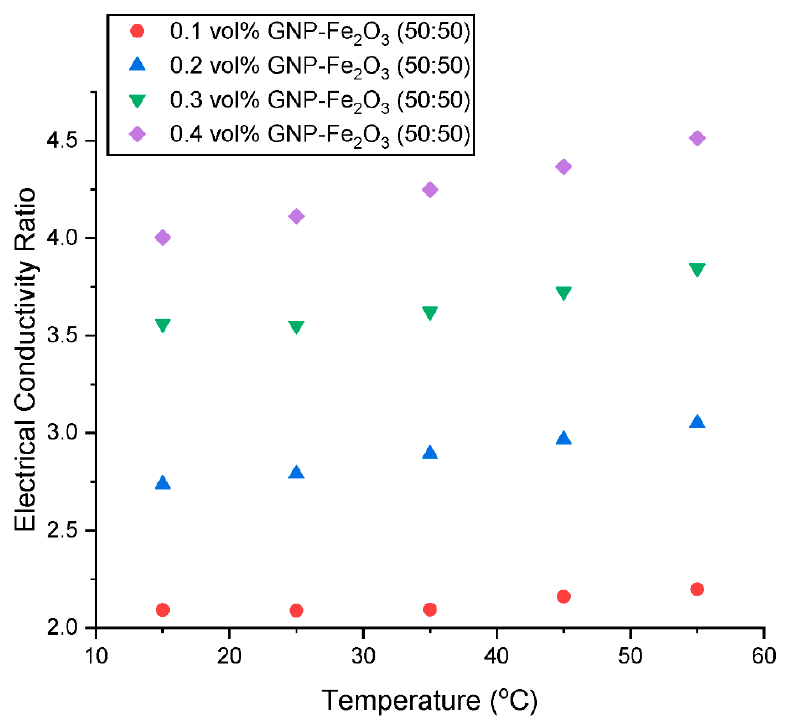
Figure 15. Influence of concentration on the electrical conductivity ratio of the hybrid nanofluids at various temperatures.